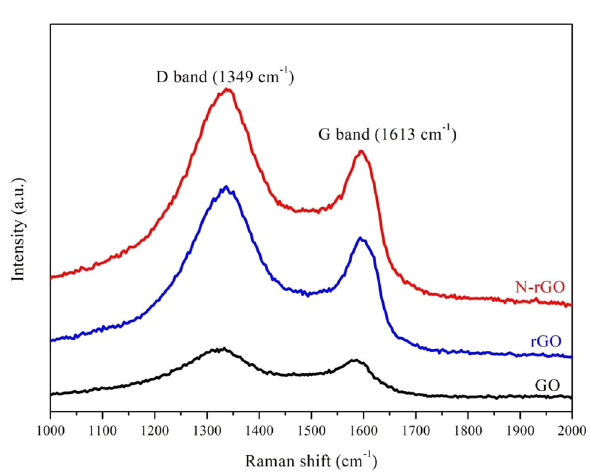
Figure 5. Raman spectra of GO, rGO, and N-rGO.